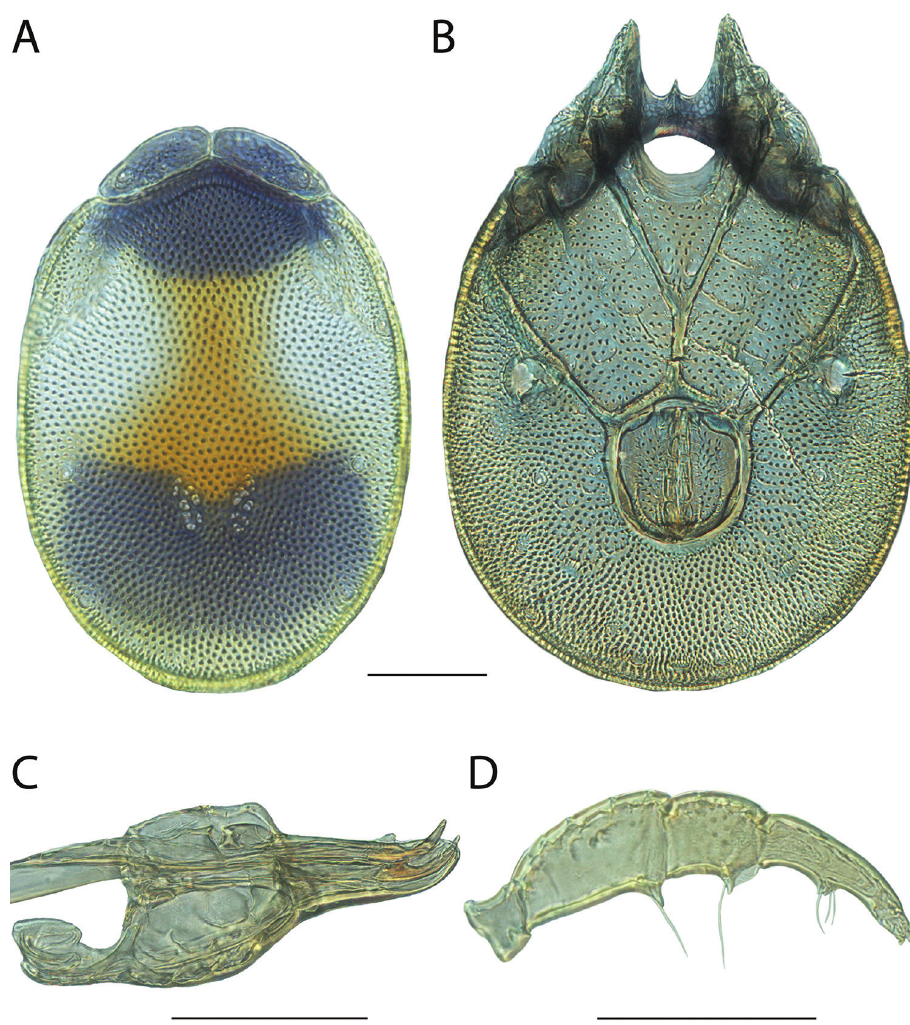
Figure 26. Torrenticola biscutella sp. n. male: A dorsal plates B venter (legs removed) C subcapitulum D pedipalp (setae not accurately depicted). Scale = 100